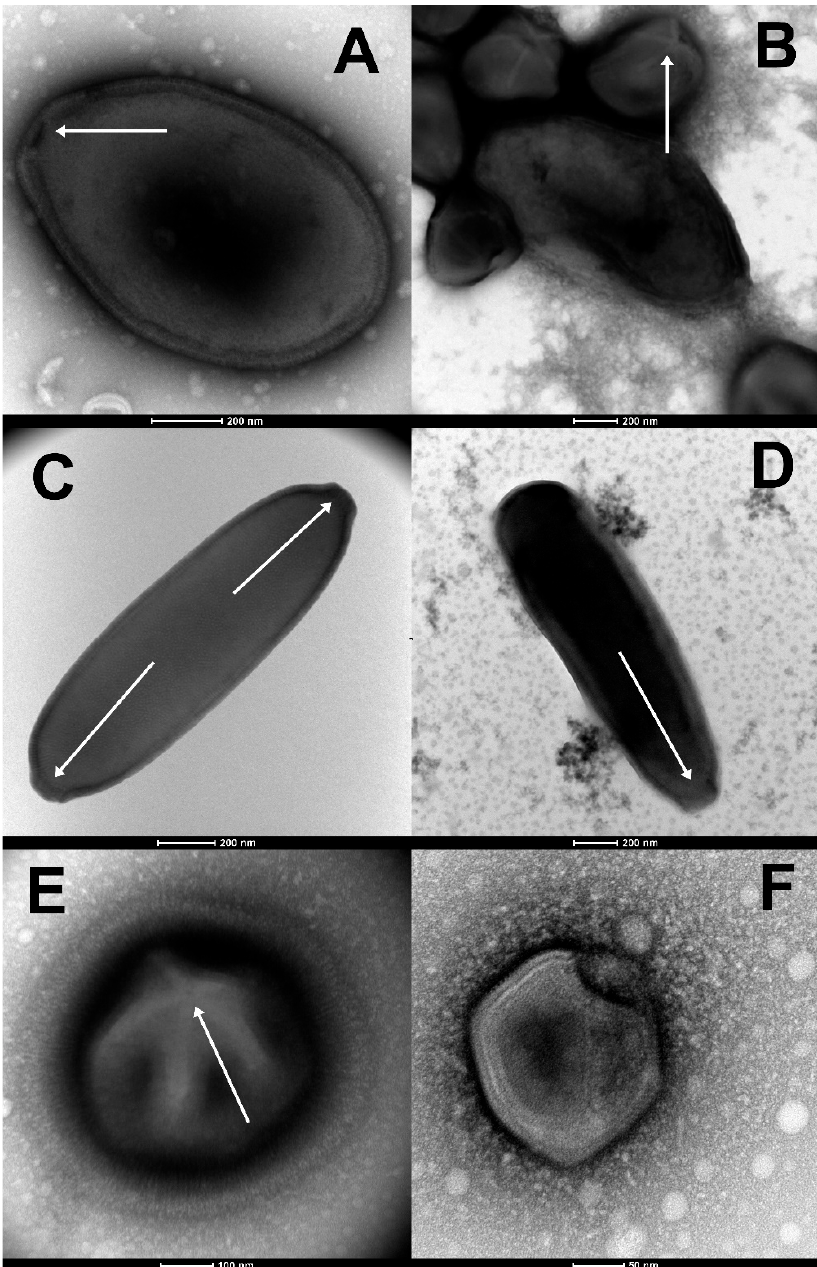
reference sequence in P. salinus . New isolates are indicated in bold.